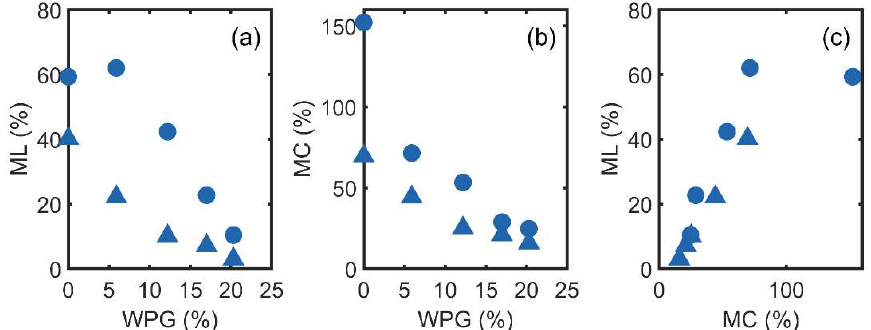
Figure 1. The interrelationship between the amount of acetylation, mass loss caused by decay, and wood moisture content at the end of the test. ( a ), mass loss as a function of weight percent gain. ( b ) final moisture content as a function of weight percent gain. ( c ) mass loss as a function of the final moisture content. The data replotted from Forster [10] , ▲ = Gloeophyllum trabeum and ●= Coniophora puteana .